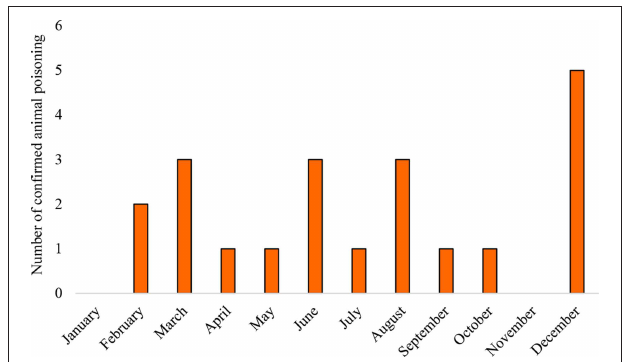
FIGURE 6 | Mean number of confirmed animal poisoning cases per month during 2014–2017.